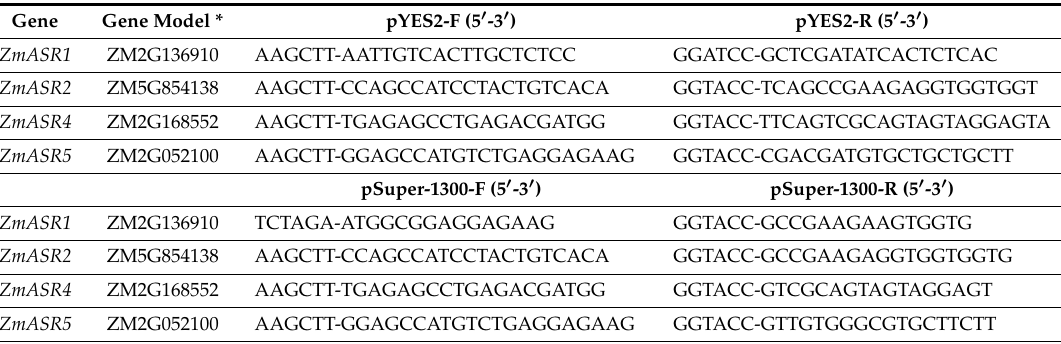
Table 1. Primers for construction of ZmASRs in yeast and tobacco transient expression